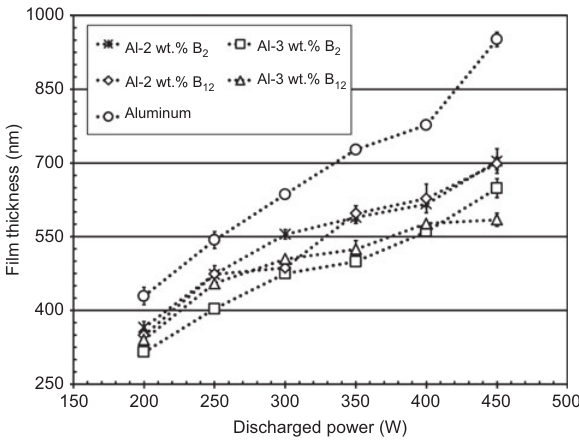
Figure 3 Film thickness as a function of discharge